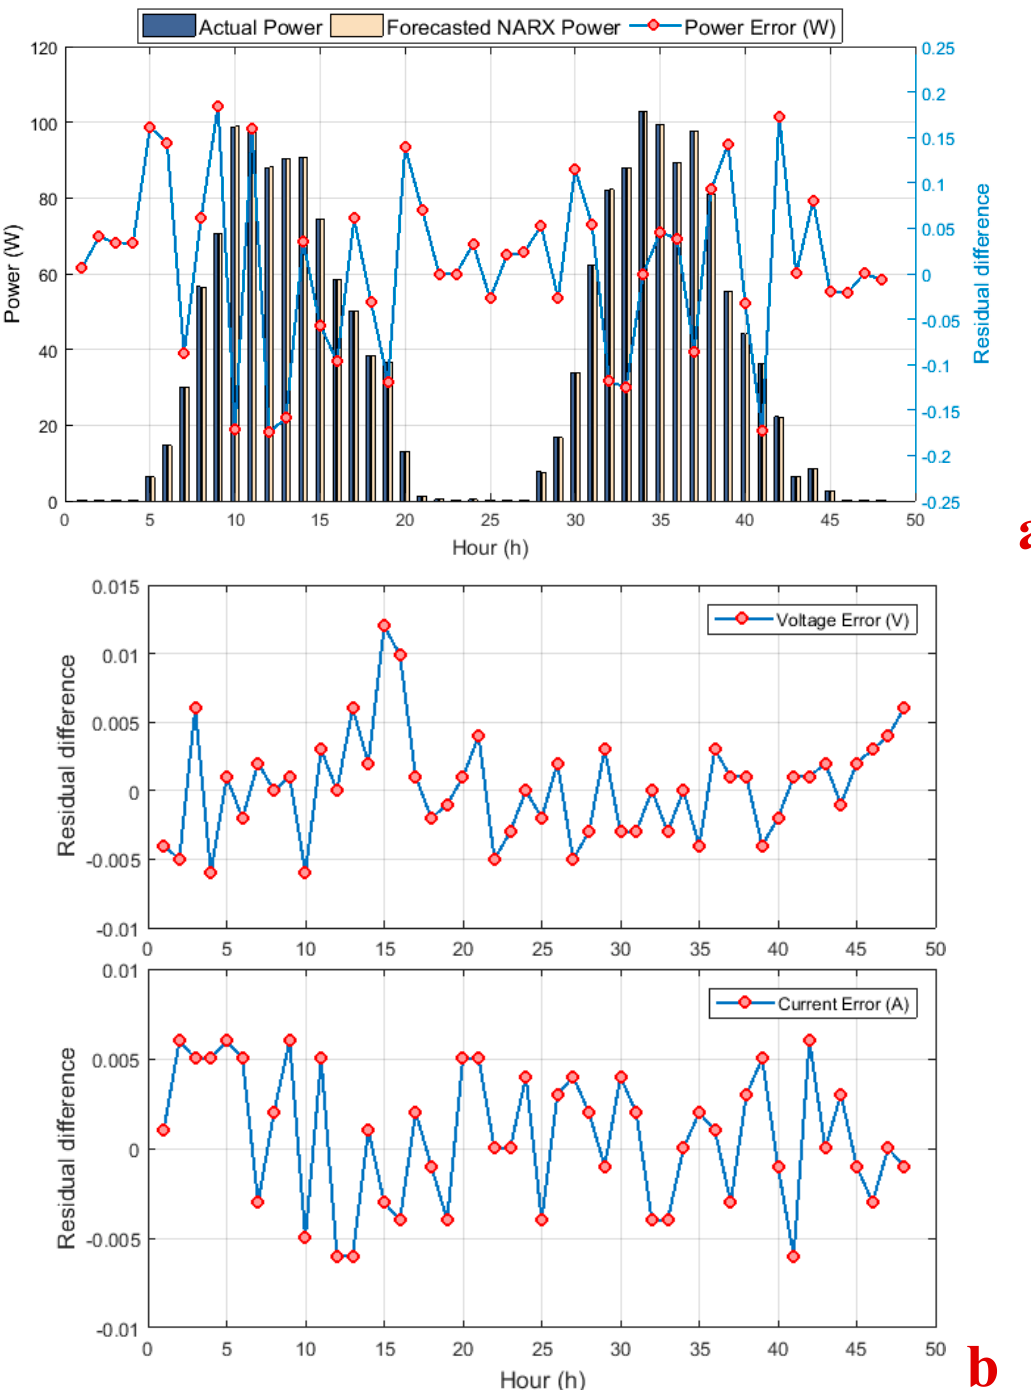
Figure 11. Real time comparison using the Astronergy-CHSM6610P PV panel ( a ) between the actual power and simulated NARX network ( b ) NARX voltage and current errors.